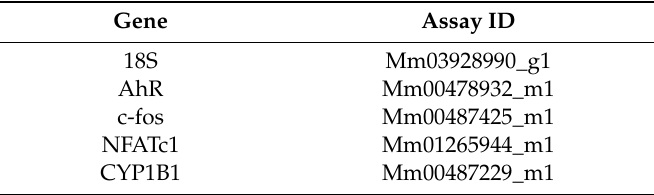
Table 1. TaqMan mRNA pre-formulated gene specific primer assay